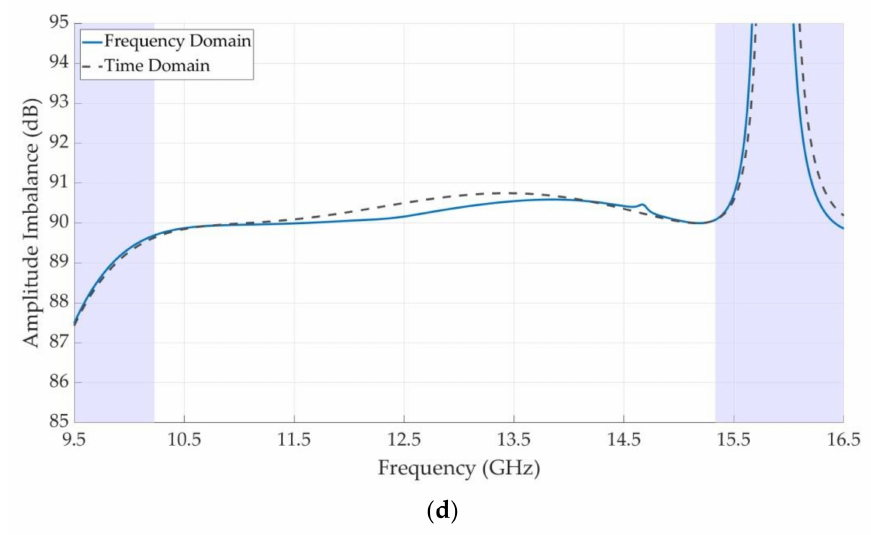
Figure 2. Hybrid coupler 1 (HC1) simulated performance. ( a ) Frequency-domain scattering parame- ters. ( b ) Time-domain scattering parameters. ( c ) Amplitude imbalance. ( d ) Phase difference.